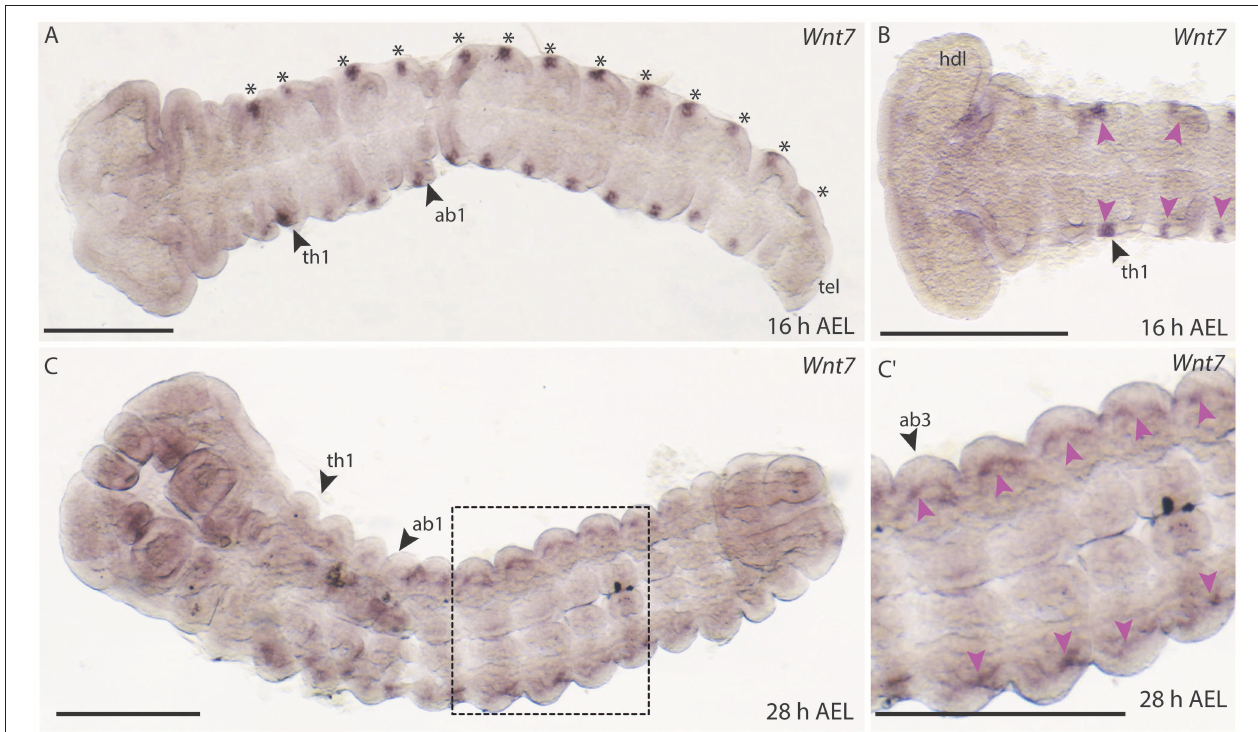
FIGURE 9 | Expression of Wnt7 during development in B. anynana. (A) The first expression of Wnt7 occurs around 16h AEL (asterisks). (B) Close up of the anterior head region indicating small lateral domains in each segment (pink arrowheads). (C) Around 28h AEL faint expression can still be detected lateral in each segment. (C ′ ) Close up of the ventral abdominal part of the embryo around 28h AEL. Expression indicated by pink arrowheads. All pictures are orientated with anterior to the left if not otherwise stated. ab1, abdominal segment 1; AEL, after egg laying; atr, antennal rudiment; h, hours; hdl, head lobe; tel, telson; th1-3, thoracic segment 1-3. All pictures are orientated with anterior left. Scale bar: 400 µ